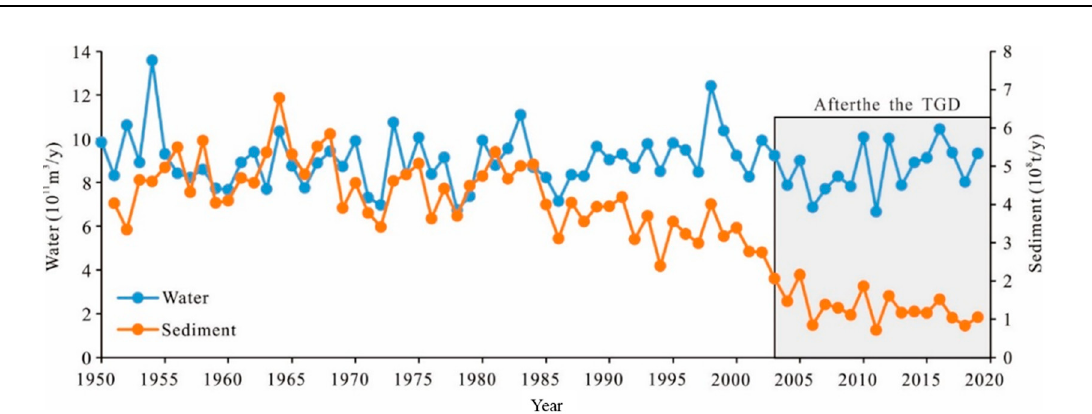
Figure 2. Variation of flow and sediment discharge of the Datong Hydrological station since 1950.